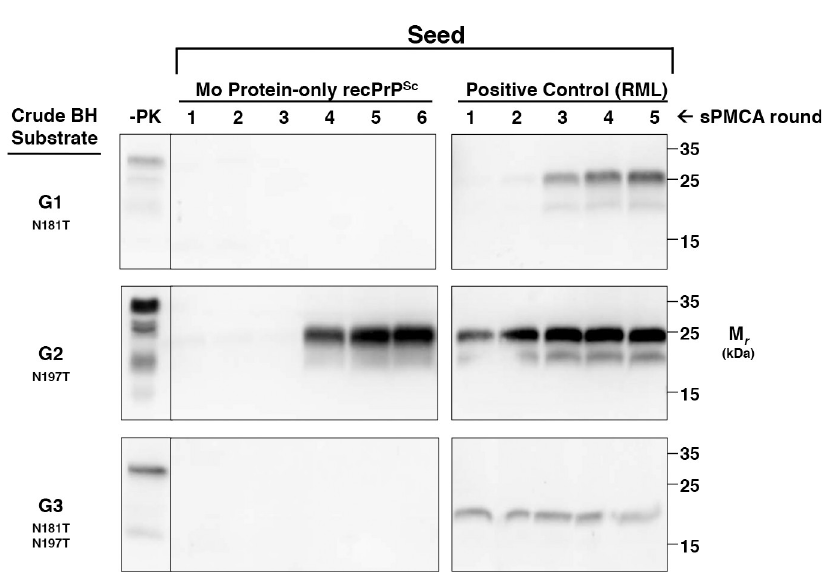
Fig 8. Propagation of Mo protein-only recPrP Sc in sPMCA reactions with glycosylation-deficient PrP C substrates. Western blots of sPMCA reactions using brain homogenates from glycosylation mutants G1, G2, or G3 as substrates, as indicated. Reactions were seeded with Mo protein-only recPrP Sc or RML, as indicated. -PK = samples not subjected to proteinase K digestion; all other samples were proteolyzed. Mouse amino acid numbering scheme is used to show locations of N-linked glycans on Mo